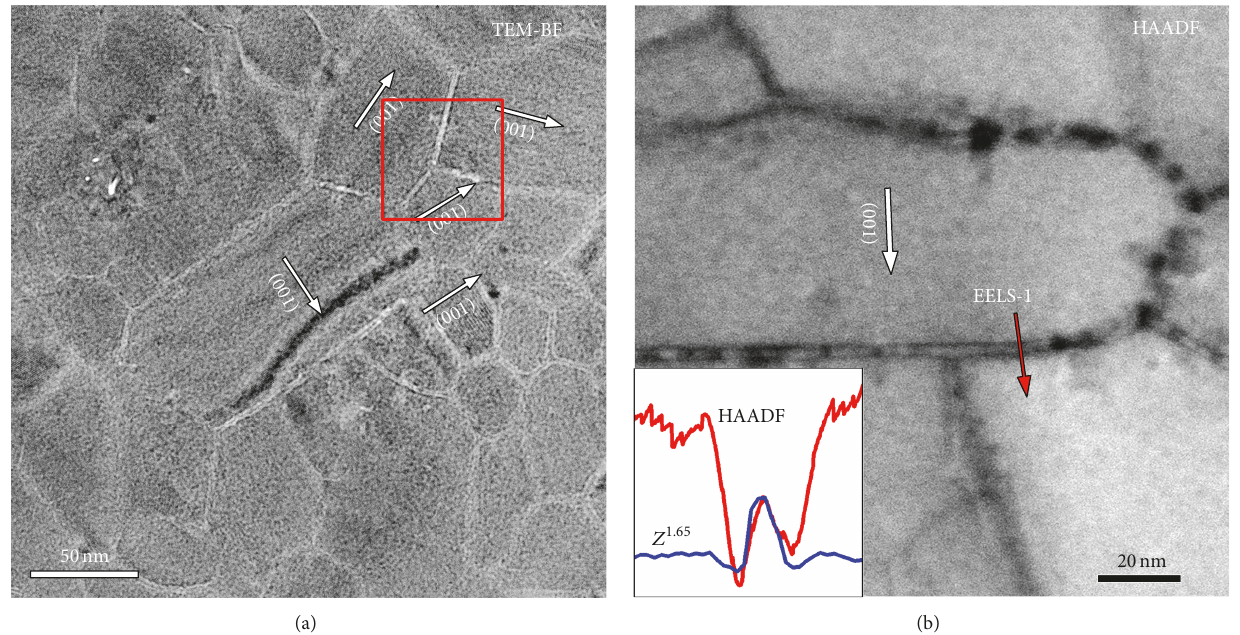
Figure 4: (a) TEM-BF image showing several misaligned grains with the marked [001] directions and the framed section of the HRTEM image of Figure 6. (b) HAADF image (cl = 30 mm) with the EELS-1 line scan (Figure 7) across GB with a double contrast. Insert in (b) correlates the double contrast of the GB (HAADF signal (red)) and the average 𝑍 1.65 (blue) along the EELS-1 line scan.